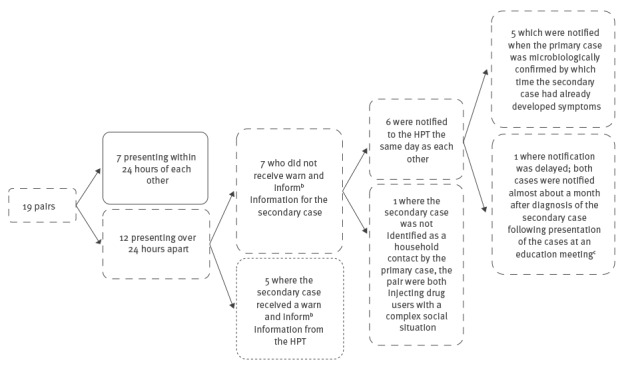
Public health management of iGAS infection clusters, England, 2011–2013a